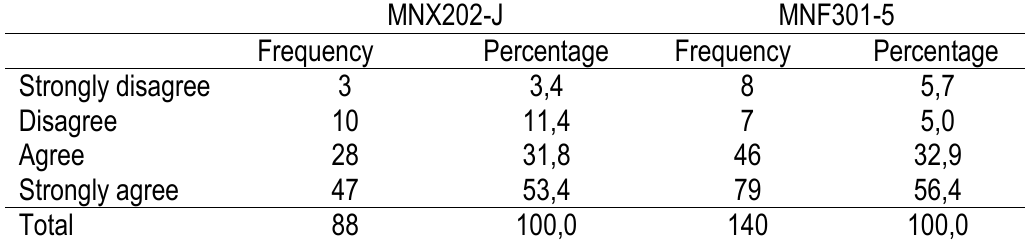
Table A1. I welcome the inclusion of an assignment mark in the final assessment mark